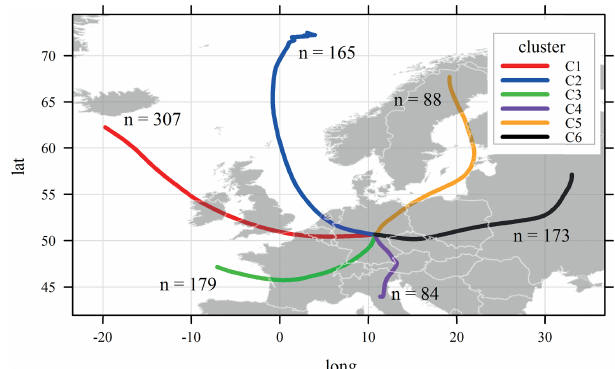
Figure 9. Cluster results of the 96h backward air mass trajectories calculated for the entire sampling period. n indicates the sum of the air mass trajectories associated with each